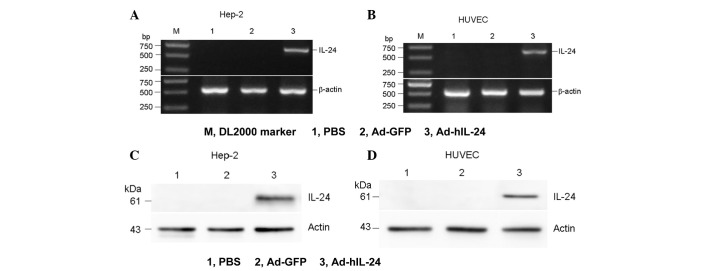
Exogenous hIL-24 messenger RNA and protein expression in Hep-2 cells and HUVECs. Total RNA and protein were obtained from Hep-2 cells and HUVECs infected with Ad-hIL-24 or Ad-GFP, serving as a blank adenovirus control or untreated cells, respectively. (A and B) First-strand complementary DNA was synthesized from RNA using reverse transcription. Polymerase chain reaction was conducted using primer sets specific for IL-24 and the housekeeping gene, β-actin, was used as an internal control. (C and D) Western blot analysis detected IL-24 protein expression in Hep-2 cells and HUVECs. HUVECs, human umbilical vein endothelial cells; IL, interleukin; PBS, phosphate-buffered saline.